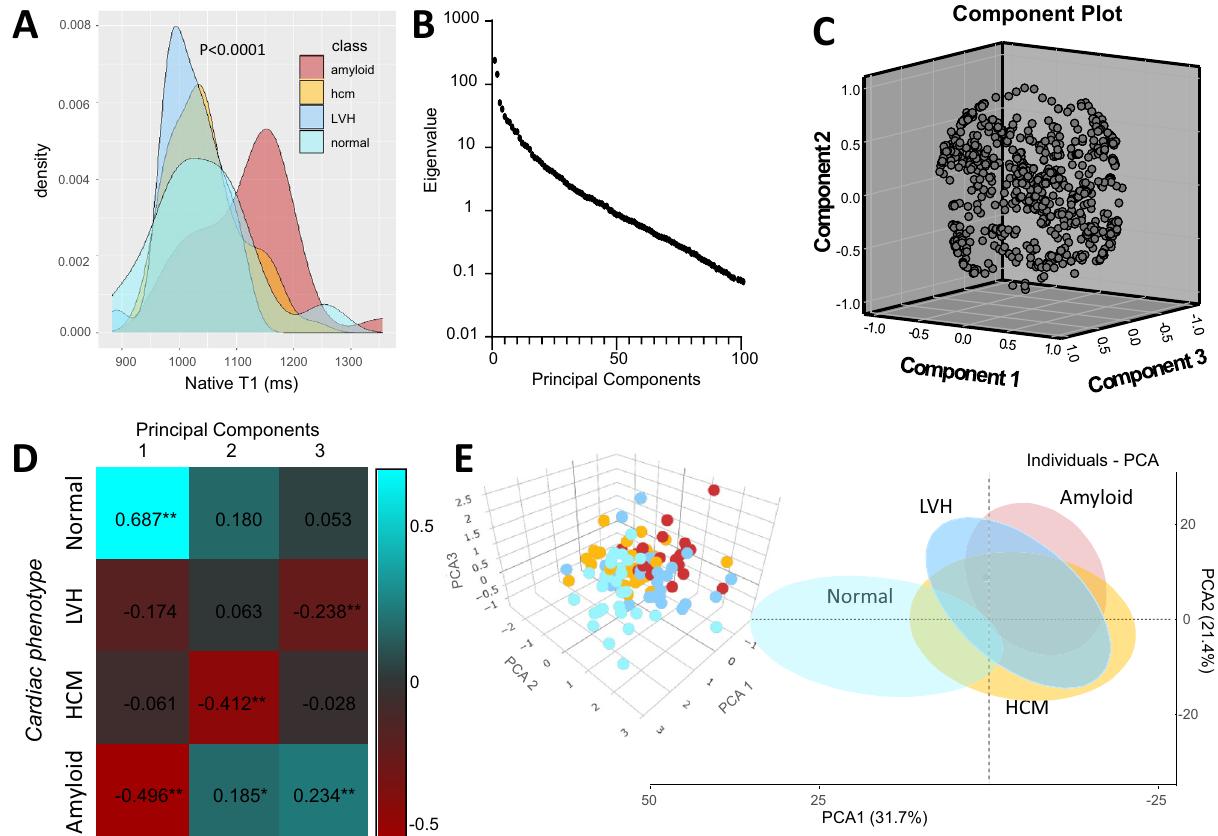
Figure 2. ( A ) Density plots for myocardial native T1 values for the population subgroups. ( B ) Dotplot of the eigenvalue vs principal components of T1 radiomics. ( C ) Cloud plot of the first three principal components of T1 radiomics for the observation of the whole study population (Arm 2) and ( D ) correlations with cardiac phenotypes. ( E ) Cloud plot of the first three principal components (PCAs) for the observations of Arm 2 colored by disease background (right) and two-dimensional scatterplot of the first two PCAs with the ellipsoid shaded areas denoting the 95% confidence intervals for the observations included in each subgroup. HCM hypertrophic cardiomyopathy, LVH left ventricular